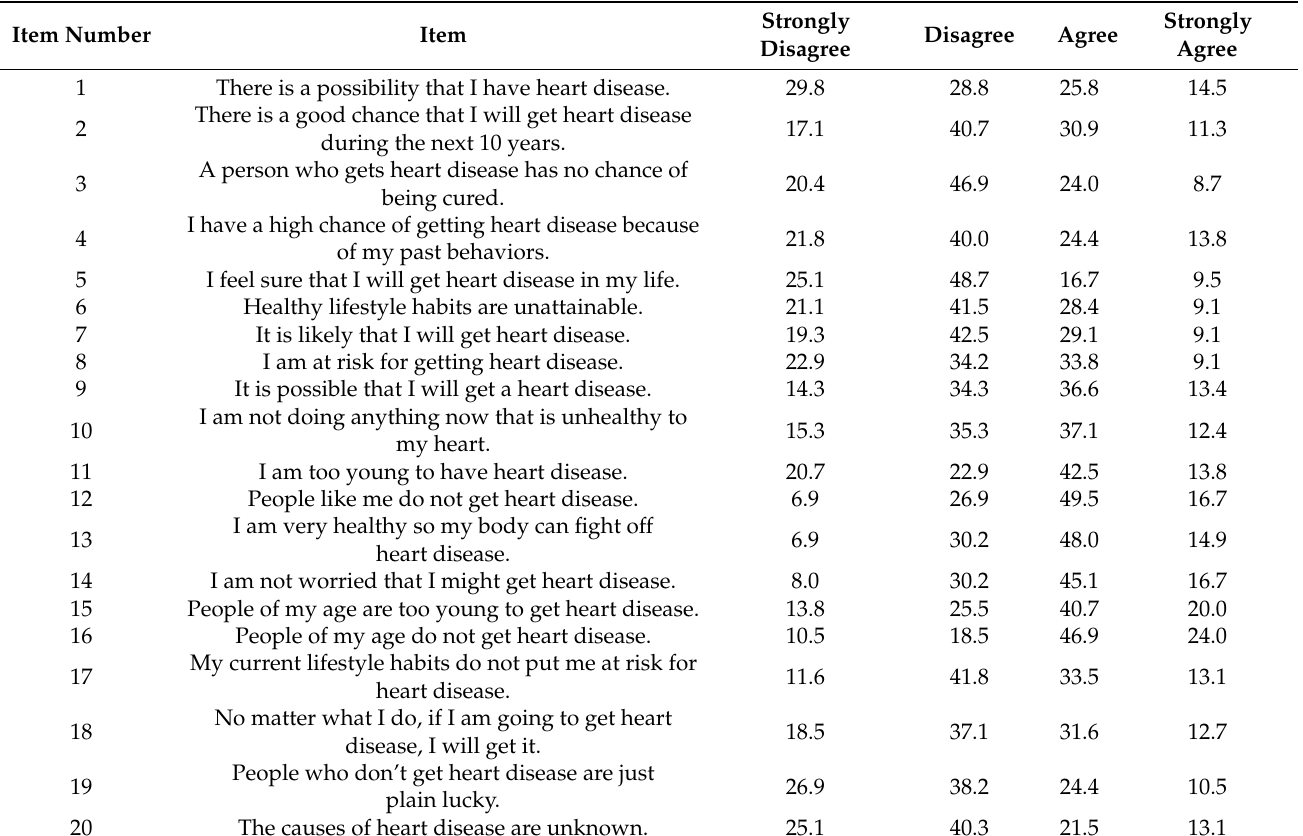
Table 2 represents the differences in the PRHDS mean scores of participants by de- mographic profile. One-way analysis of variance and independent t -test did not reveal any significant differences in mean scores for PRHDS regarding age, gender, employment status, or monthly income. However, there was a significant difference in the mean score for PRHDS in participants’ family history of heart disease ( p < 0.05). The PRHDS mean score of participants who have a family history of heart disease (25.32 ± 2.81; n = 556) was significantly higher than the mean score of the rest of the participants (22.14 ± 3.42; n = 76), p =